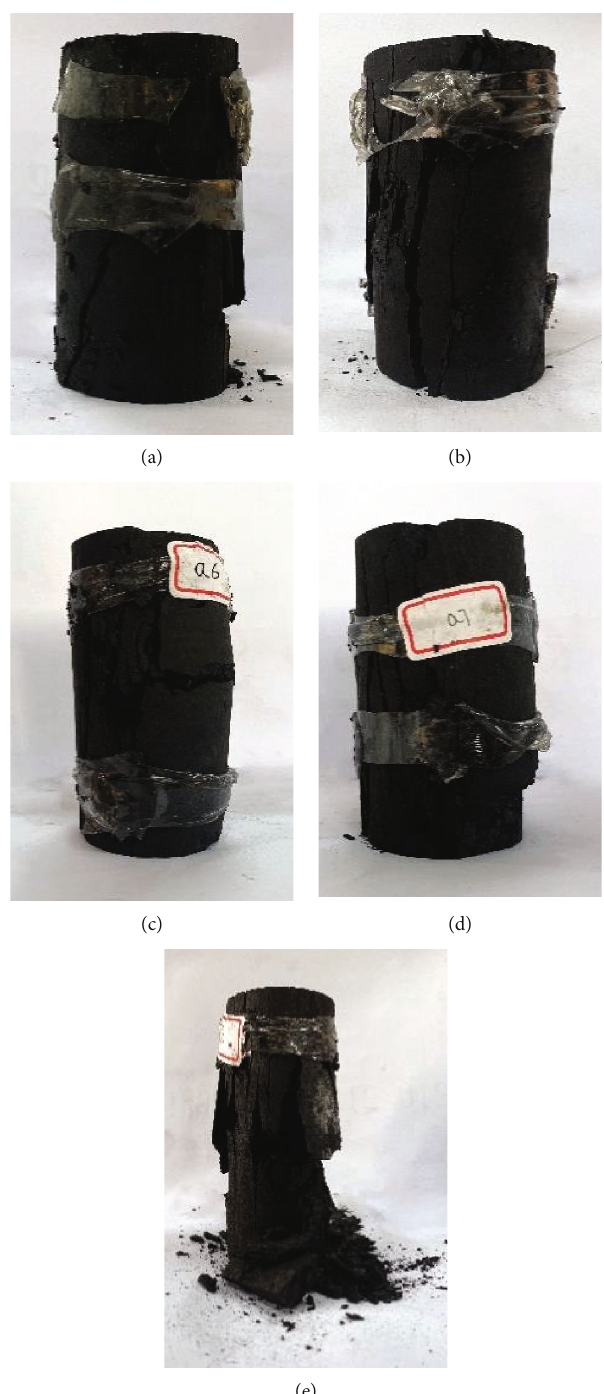
Figure 9: Broken states of coal samples with di ff erent moisture contents ((a) 16%; (b) 17%; (c) 20%; (d) 21%; (e)